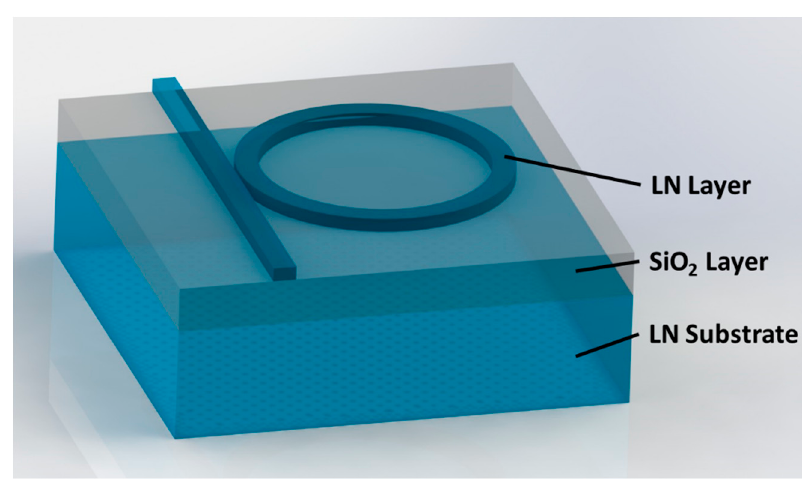
Figure 1. A schematic of the waveguide ‐ coupled microring resonator on LNOI.